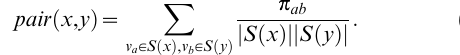
Table 1. The Size of Predictable Protein Pairs in